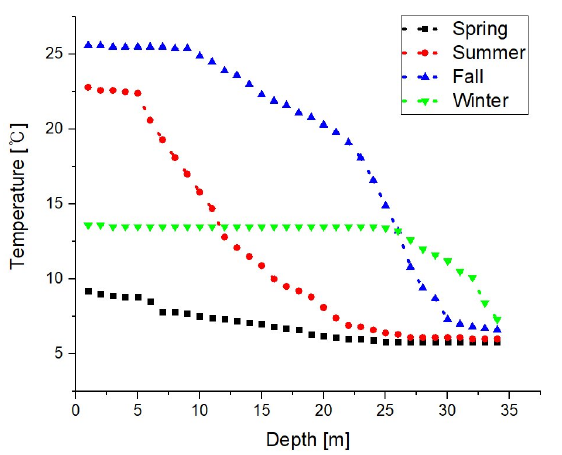
Figure 3. Variation of water temperature by